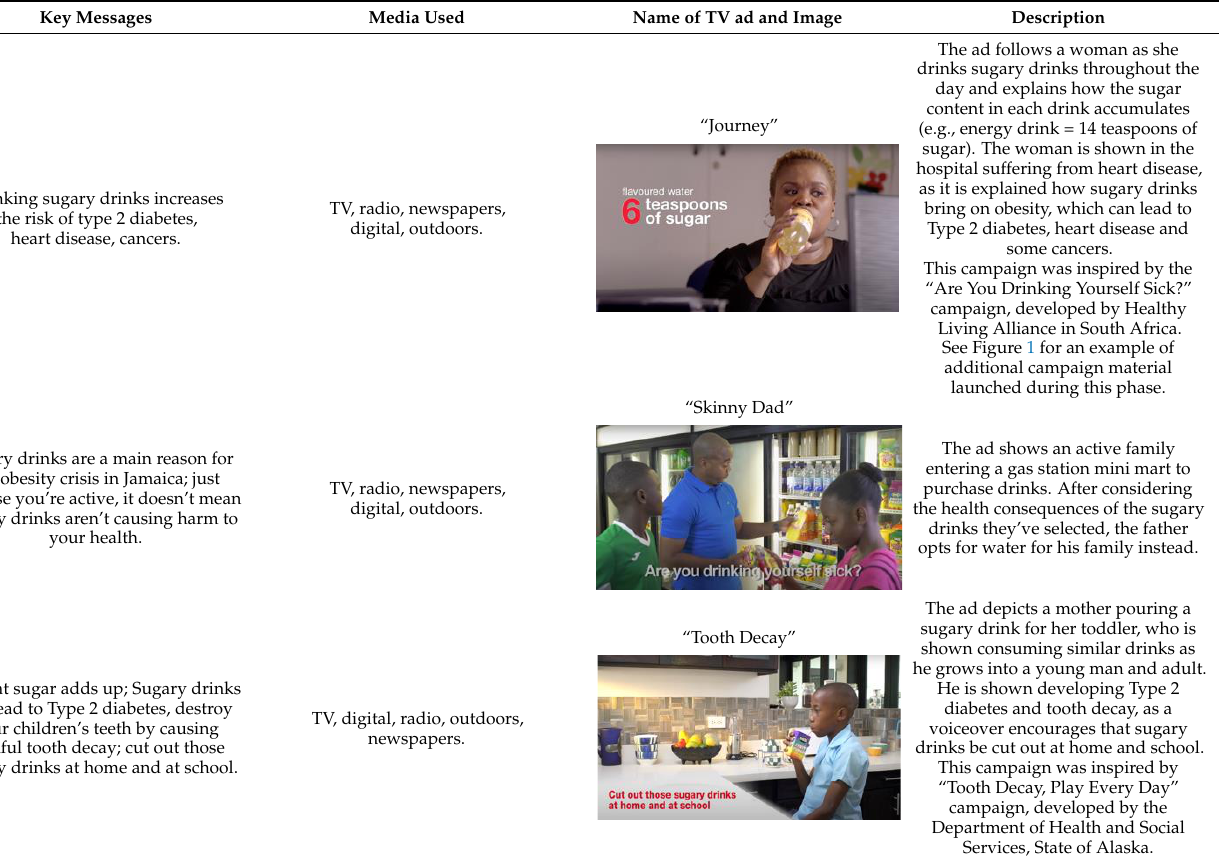
Table 1. Campaign details with key messages.